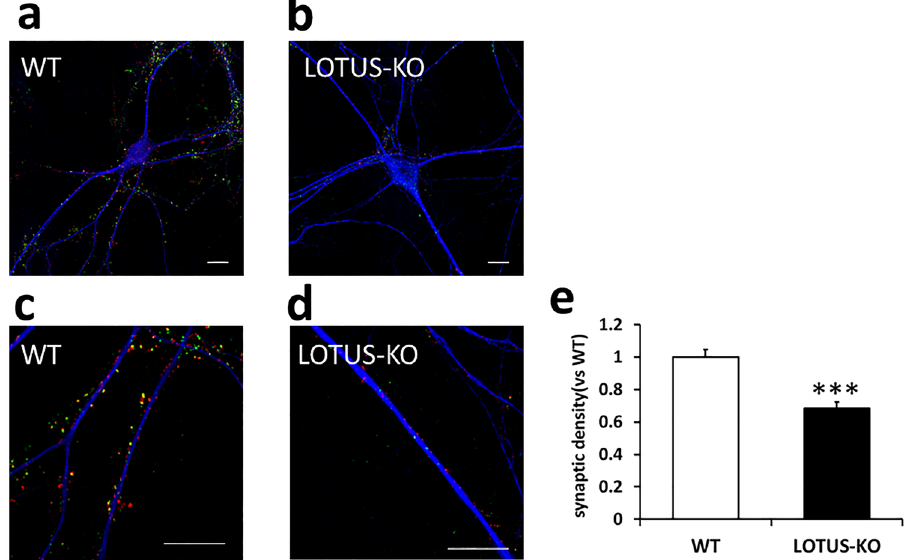
Figure 2. Loss of LOTUS decreases the density of PSD95/Bassoon puncta in cultured hippocampal neurons. ( a , b ) Cultured hippocampal neurons (DIV 14) derived from WT ( a ) and LOTUS-KO ( b ) mice. Neurons were immunostained with antibodies against Bassoon (red), PSD-95 (green), and MAP2 (blue). Scale bars, 10 µm. ( c , d ) Magnified images from ( a ) and ( b ). The segment was imaged at 3 × magnification. Scale bars, 10 µm. ( e ) Quantification of the synaptic density of Bassoon/PSD95 puncta along the dendrites of each neuron. Data were normalized to the synaptic density in WT neurons. Data are means ± SEM from four to five independent experiments. The total number of neurons analyzed (n) ranged from 16 to 20 cells per condition. *** P < 0.001, Student’s unpaired t